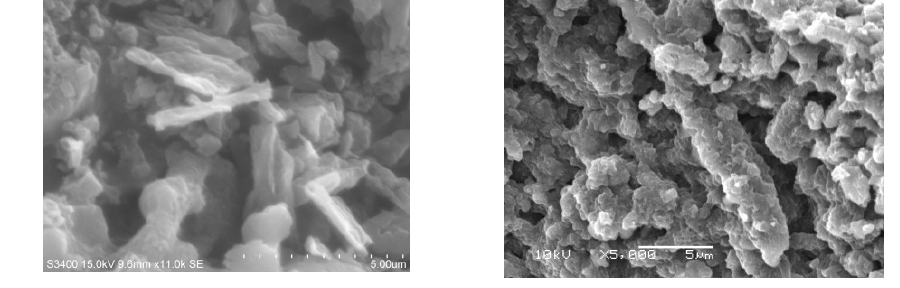
doped tetraaniline under N